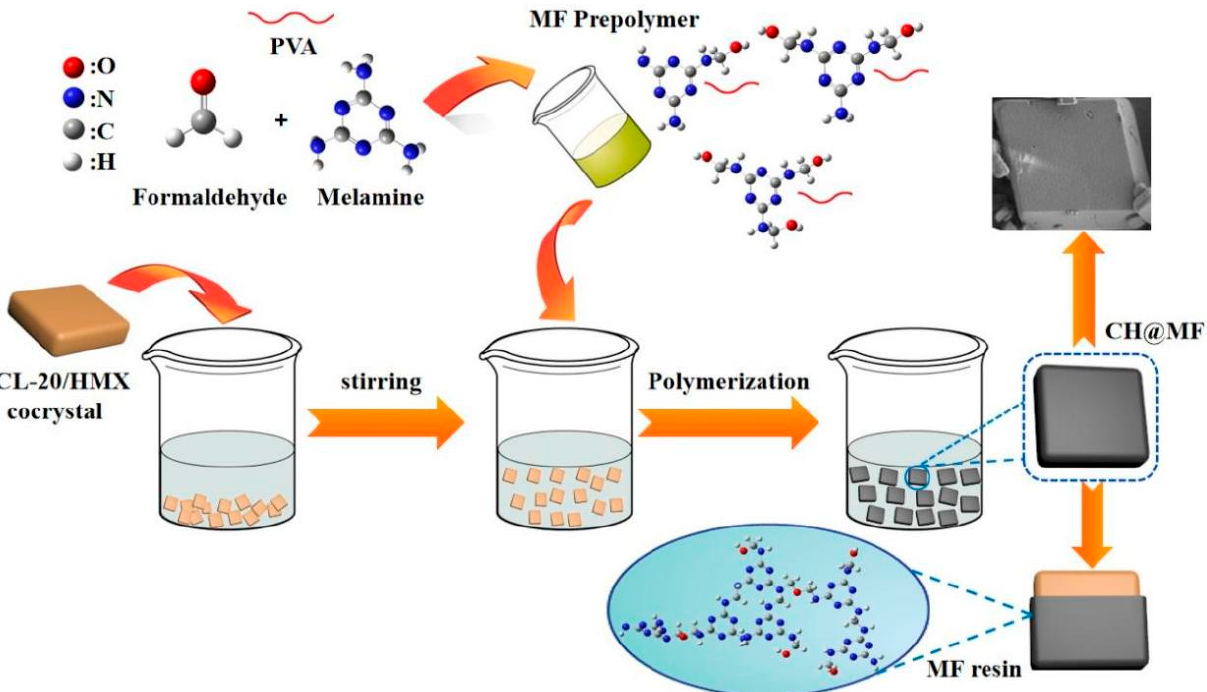
Figure 11. Proposed formation mechanism of the CH@MF composites.